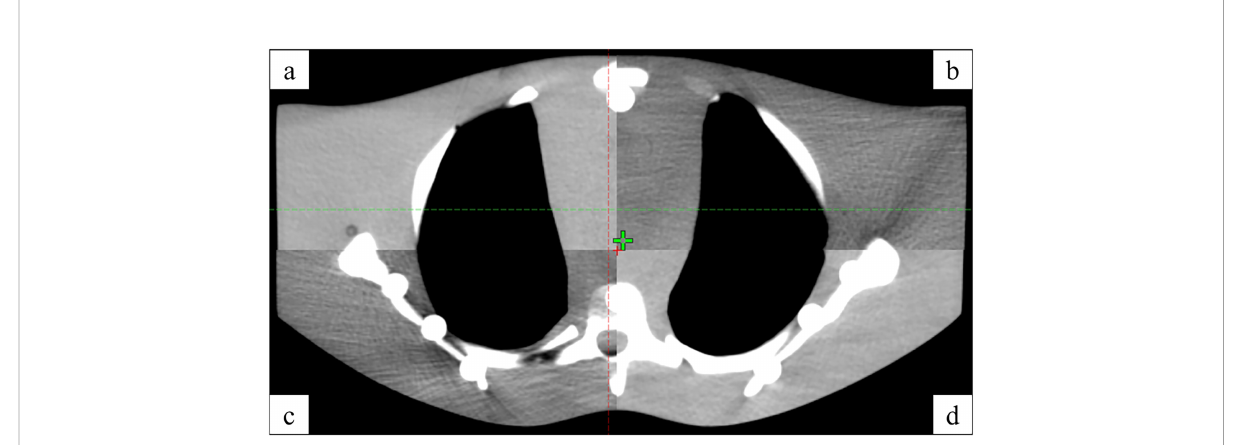
TABLE 1 Errors at different registration angles.